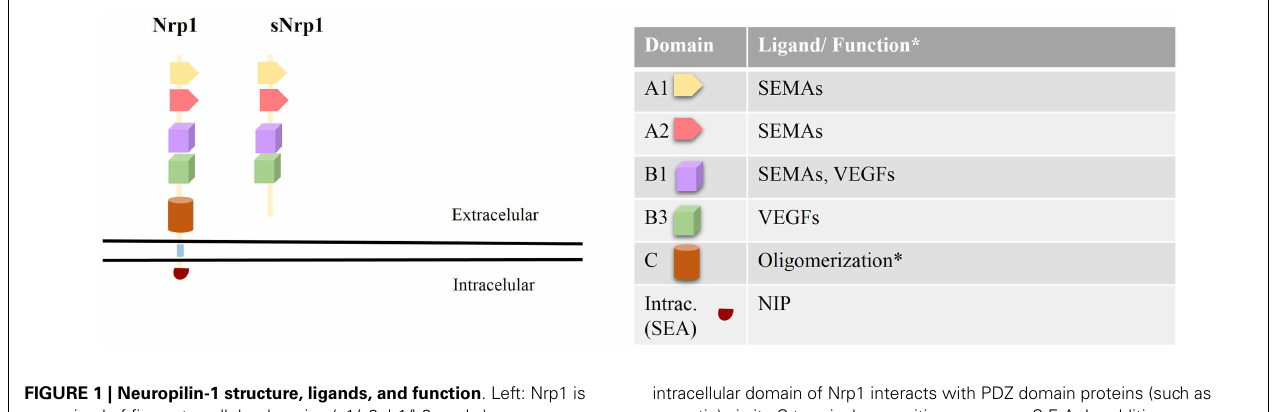
FIGURE 1 | Neuropilin-1 structure, ligands, and function . Left: Nrp1 is comprised of five extracellular domains (a1/a2, b1/b2, and c), one transmembrane domain, and a short cytoplasmic domain.The a1/a2 and b1/b2 domains are involved in binding to several ligands, while the c- and transmembrane domains are involved in receptor oligomerization.The